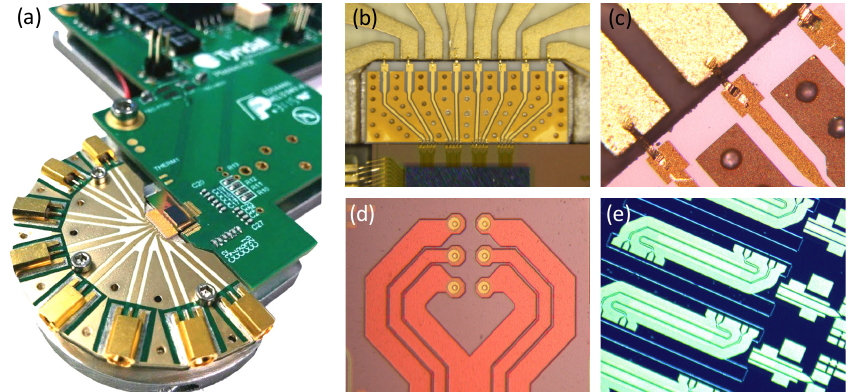
Figure 11. Examples of electrical ‐ routing structures needed for high ‐ speed photonic packages; ( a ) Image of the semi ‐ circular PCB ‐ to ‐ PIC routing needed to ensure that multiple signals arrive at the same time; ( b ) Microscope image of a pitch ‐ reducing ceramic interposer used to match the minimum ‐ pitch on a standard high ‐ dielectric PCB (300 μ m) to the bond ‐ pad pitch on the PIC (100 μ m); ( c ) Microscope image of the ‘tape’ or ‘ribbon’ wire ‐ bonds used to connect the PCB to the ceramic interposer; ( d , e ) On ‐ PIC high ‐ speed transmission lines in the co ‐ planar ground ‐ signal ‐ ground geometry.